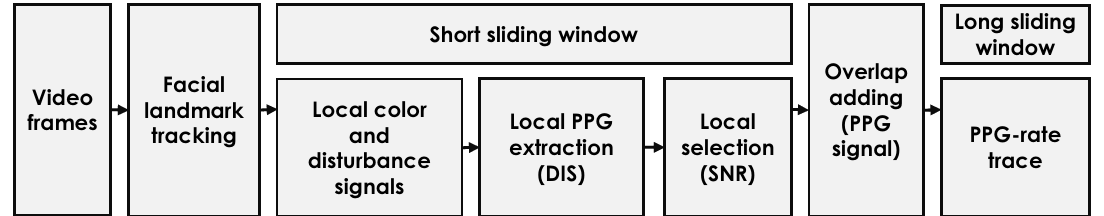
Figure 7. The architecture of the processing unit used for end-to-end pulse-rate extraction from a video